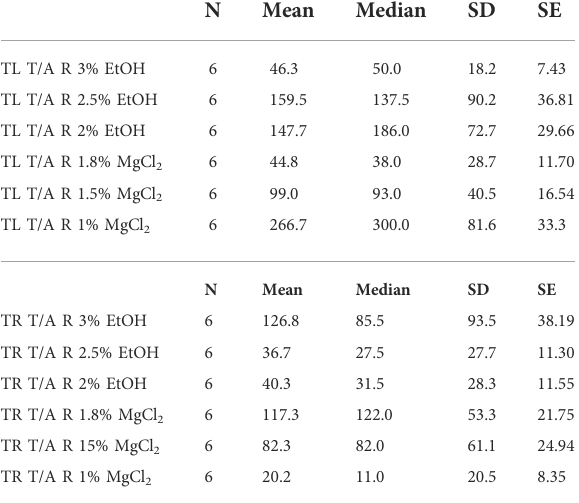
TABLE 5 Time until loss of tentacles/arms response in seconds (TL T/A R)andtimetorecoveryoftentacles/armsresponseinseconds(TR T/A R) of L. vulgaris embryos exposed to different EtOH and MgCl 2 concentrations and the controls (no anesthetic solution). Measures are summarized (mean, median, SD, and